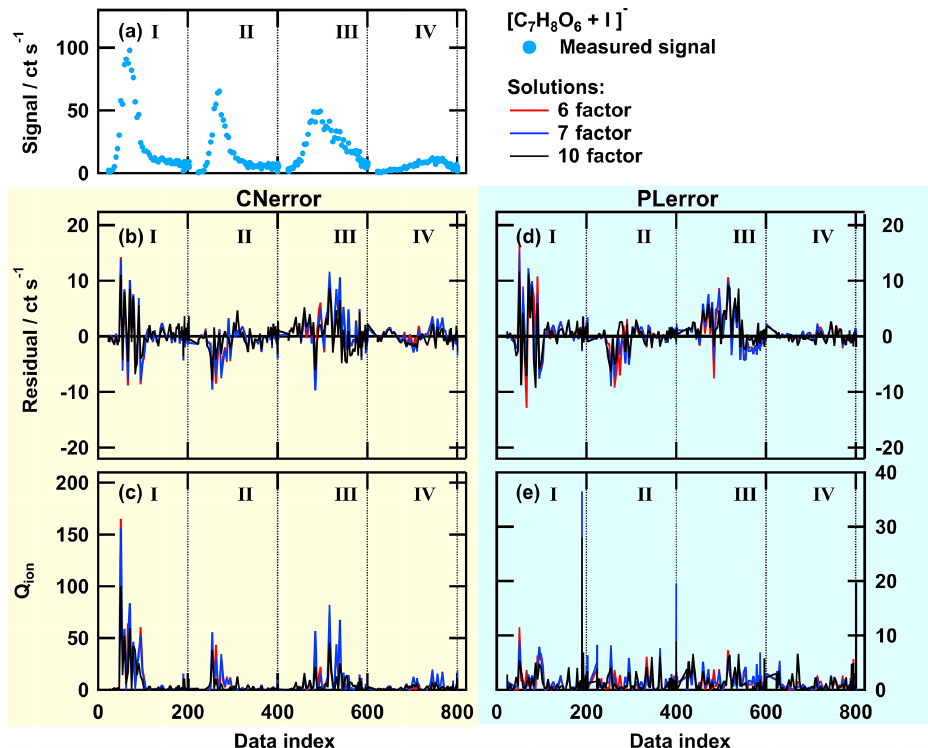
Figure A2. Single ion thermogram (a) , residuals (b, d) , and Q ion values (c, e) as time series for solutions with 6, 7, or 10 factors for PMF run with CNerror (b, c) and PLerror (d, e) for the ion [C 7 H 8 O 6 + I] − . The data set contains thermogram scans for high-O : C SOA particles for the following sampling conditions: dry – t evap = 0 . 25h (I); dry – t evap = 4h (II); wet – t evap = 0 . 25h (III); and wet – t evap = 4h (IV). Note that the y scaling in (e) is much smaller than in (c)